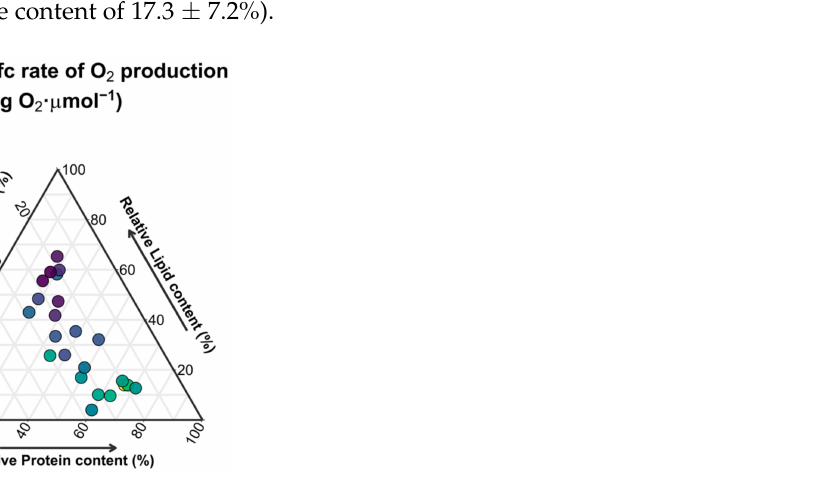
Figure 3. Chlorella vulgaris NIES 227 photosynthetic productivity under varying physiological